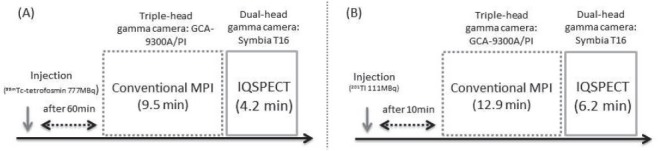
Schematic drawing of MPI SPECT, using 99mTc-tetrofosmin (A) and 201Tl (B). All images were initially acquired by conventional SPECT, immediately followed by IQ-SPECT